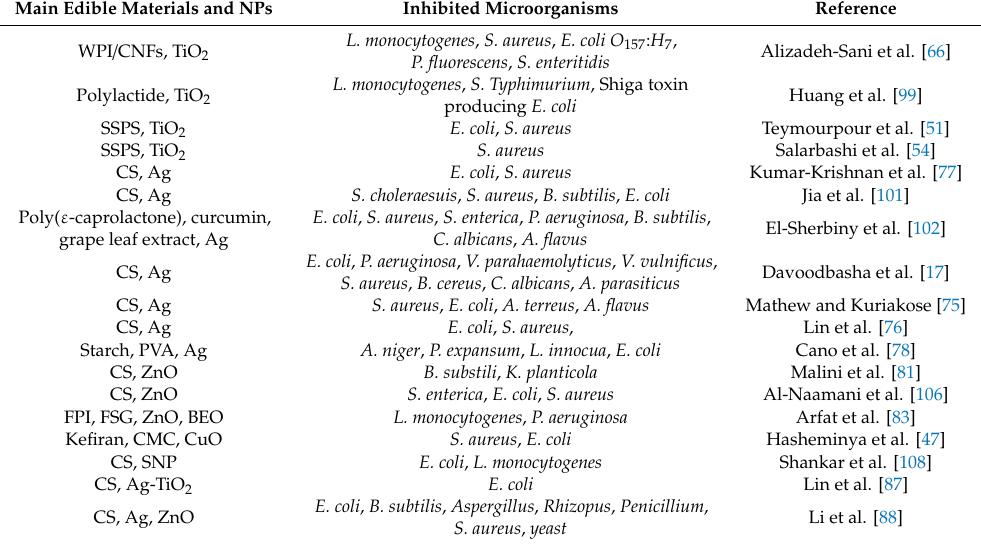
Table 2. Summary of the tested microorganisms inhibited by various ECF with